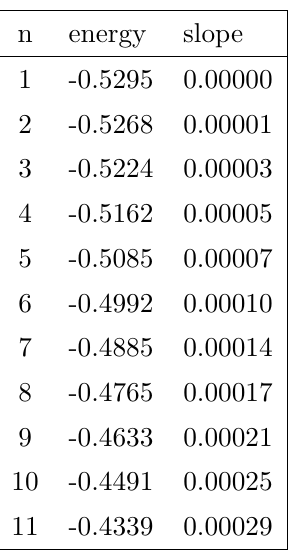
Table 1 . Numerical results for the eigenvalues and slope with (cid:12)xed coupling constant and Higgs- mass